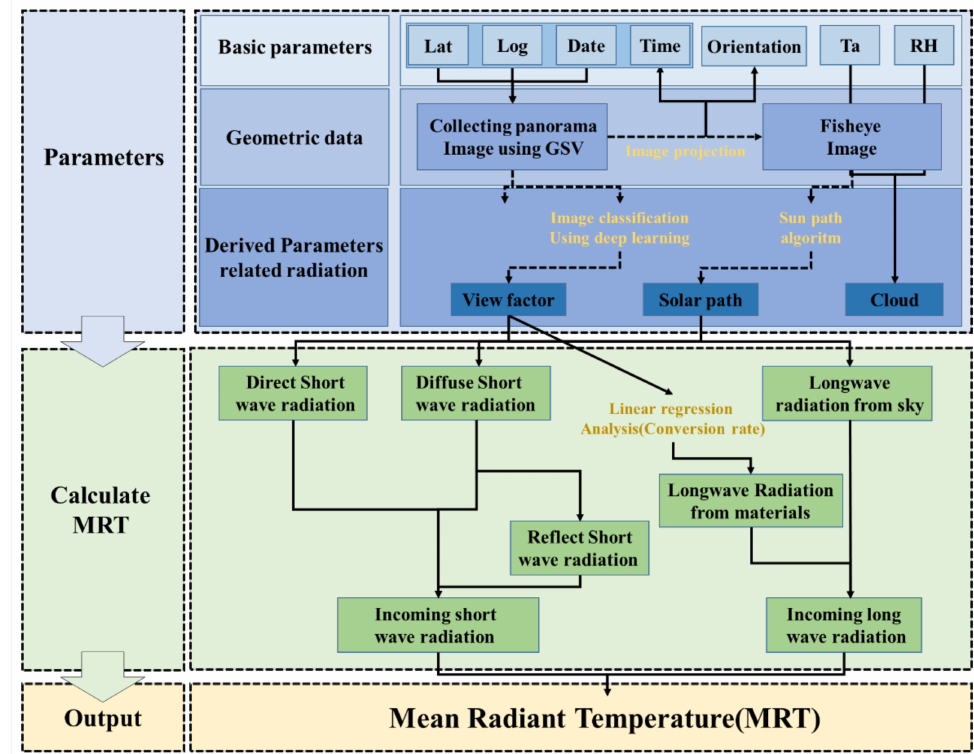
Figure 2. Schematic flow for calculating MRT using deep learning.